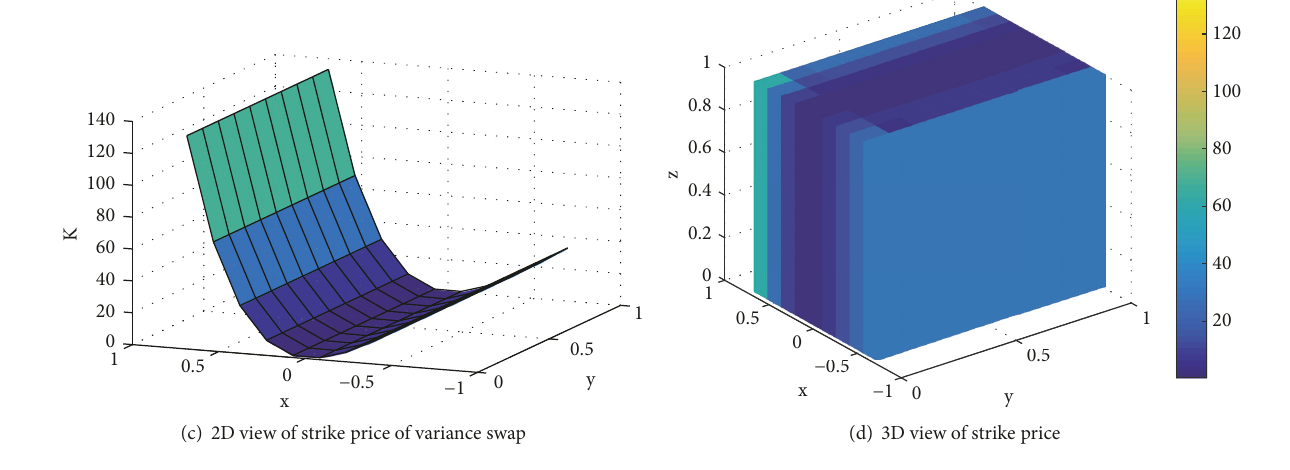
Figure 5: Option price.